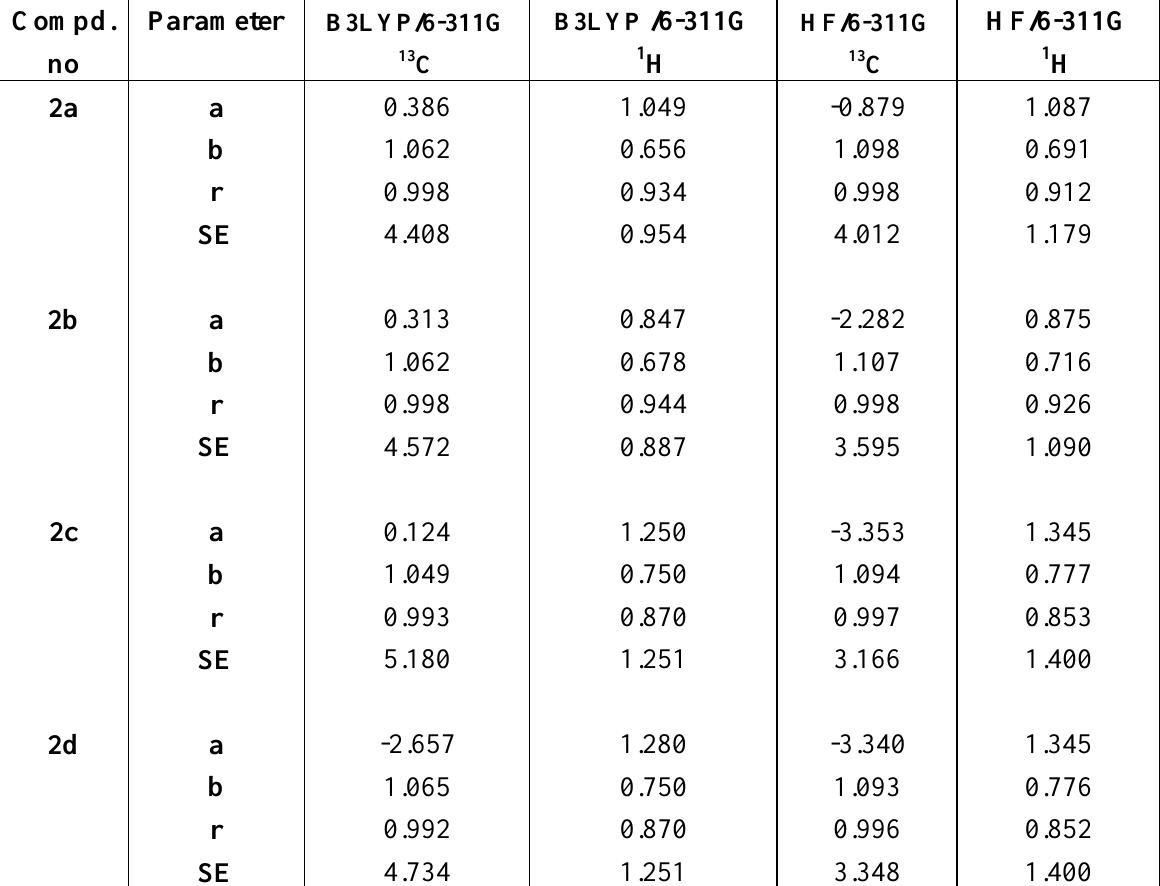
Table 5. Linear regression between experimental chemical shifts and calculated isotropic shielding